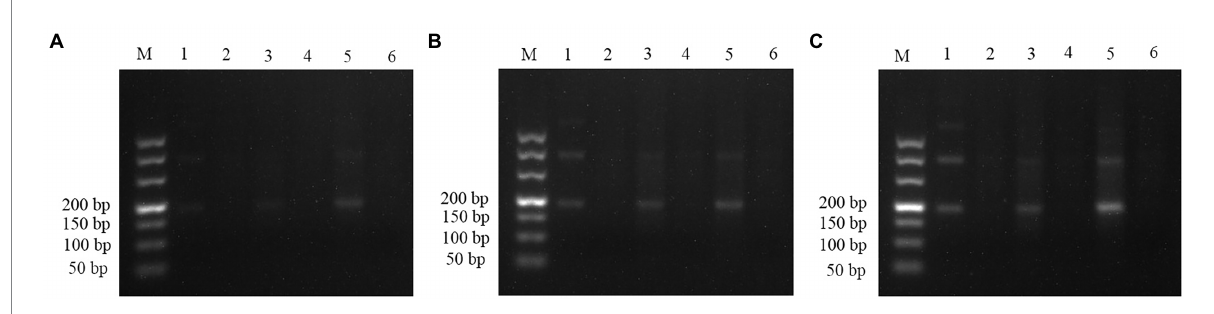
FIGURE 2 Optimization of incubation time and primer concentrations for the RPA assay. (A) Samples incubated for 10 min. (B) Samples incubated for 15 min. (C) Samples incubated for 20 min. About 1.29 × 10 7 copies/ μ L of plasmids were used as template. Lane M: DL500; the odd-numbered lanes represent assays amplified with primers concentrations of 0.2, 0.36, 0.72 μ M. The even-numbered lanes represent the negative controls (NTC) of each primer concentration.